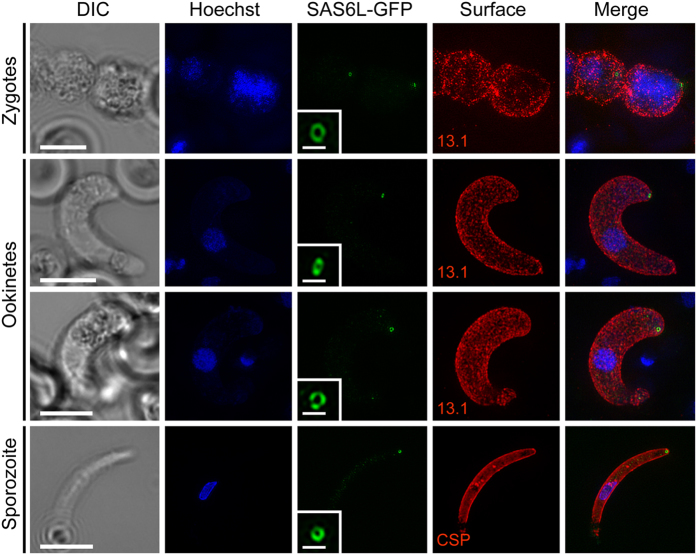
3D-SIM super-resolution images of SAS6L shows a ring structure at the apical end of the ookinete and sporozoite.Images of fixed zygotes, ookinetes, and salivary gland sporozoite at 21 days post-infection expressing SAS6L-GFP (green), co-stained with DAPI (blue), 13.1 (red: zygotes/ookinetes) or CSP (red: sporozoites). Images were selected for the orientation of the apical end of the cell facing the viewer and displaying the ring. Major scale bars = 5 μm. Insets show magnified view of SAS6L ring structures with scale bars = 500 nm.